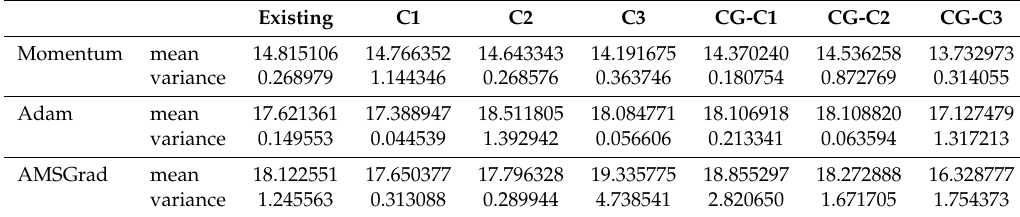
Figure 6. Classification error rate versus number of epochs on the CIFAR-10 dataset for testing (diminishing). Table 1. Mean and variance of elapsed time per epoch for the existing algorithms and Algorithm 1 on the CIFAR-10 dataset.